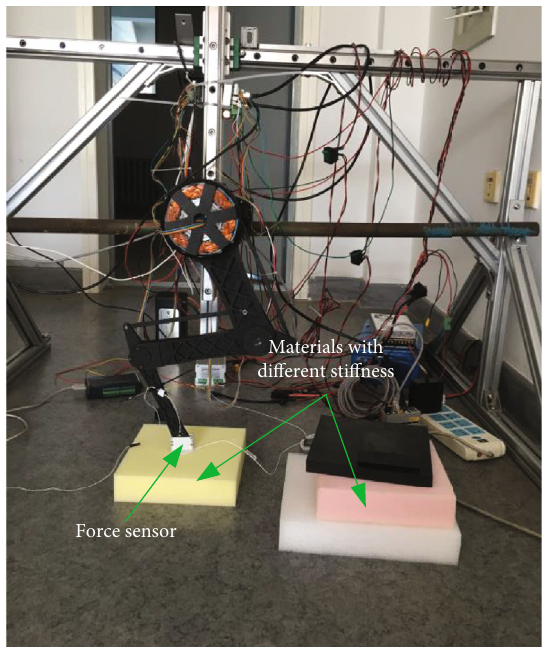
Figure 16: Diagram of the identi fi cation of various ground